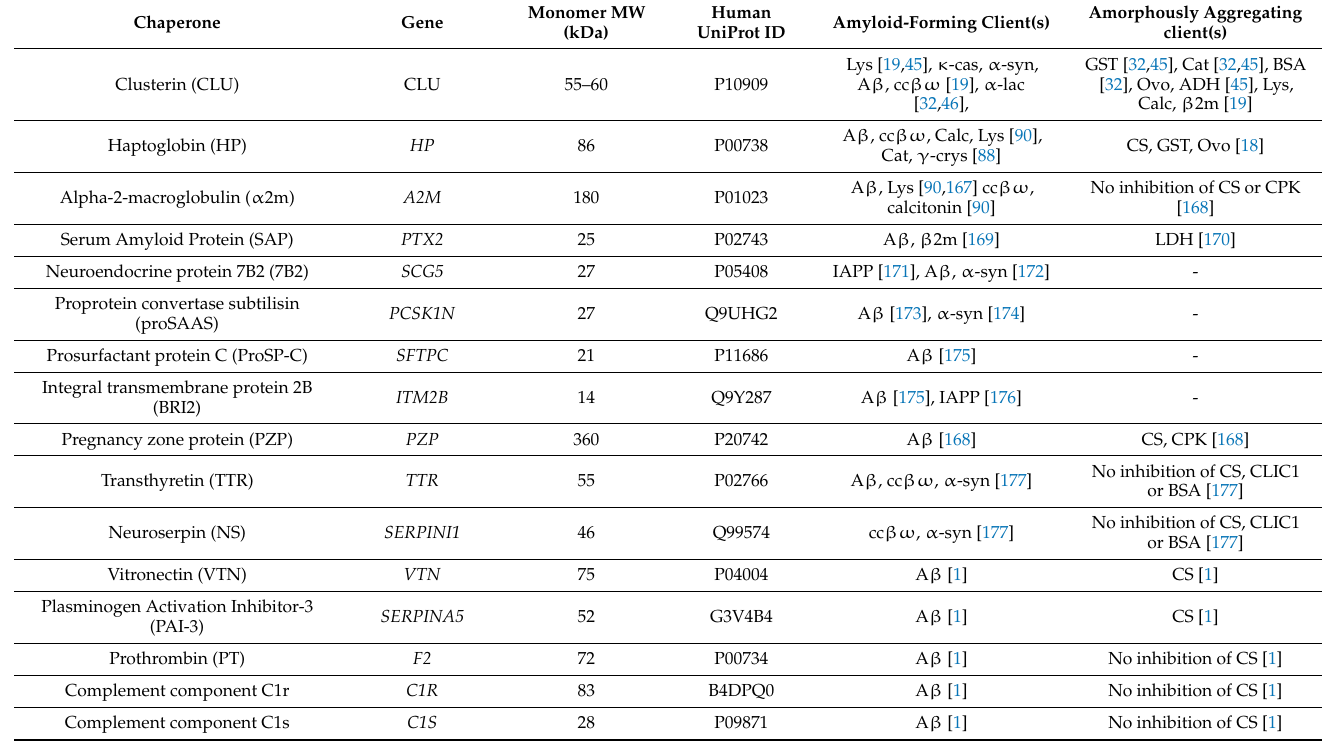
Table 1. Extracellular chaperones and details of client protein aggregation they are known to